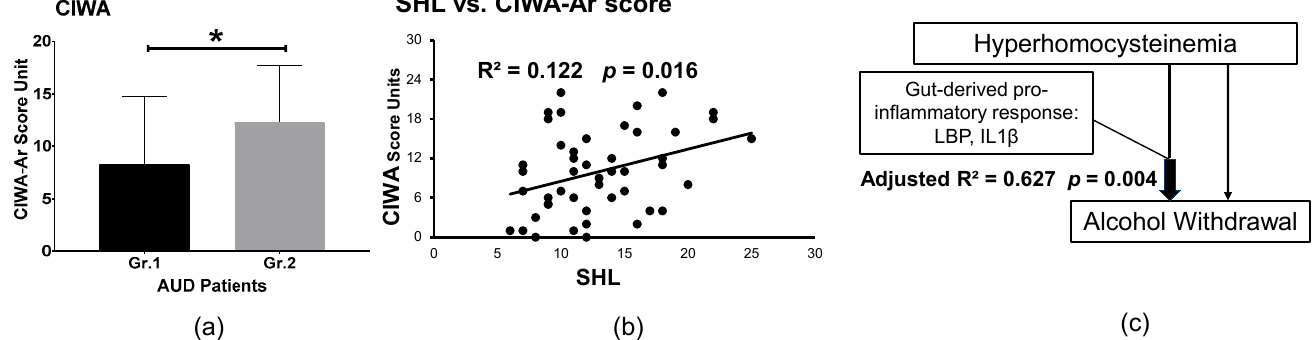
Figure 2. Role of the serum homocysteine level (SHL) in alcohol withdrawal in a sub-set of n = 47 subjects. ( a ) Significant elevation in CIWA-Ar scores in Gr.2 AUD subjects with elevated SHL. Data are presented in Figure 2a as the mean ± standard deviation. R 2 denotes the effect of the relationship as an outcome of univariate linear regression (Figure 2b) or as adjusted R 2 with multivariable analysis (Figure 2c). Statistical significance was set at * p ≤ 0.05 (Figure 2a). ( b ) Significant positive association of SHL and the CIWA-Ar score. ( c ) Role of hyperhomocysteinemia; heavy drinking marker, HDD90; and gut-derived proinflammatory response consequential in higher withdrawal ratings in Gr. 2 AUD patients.